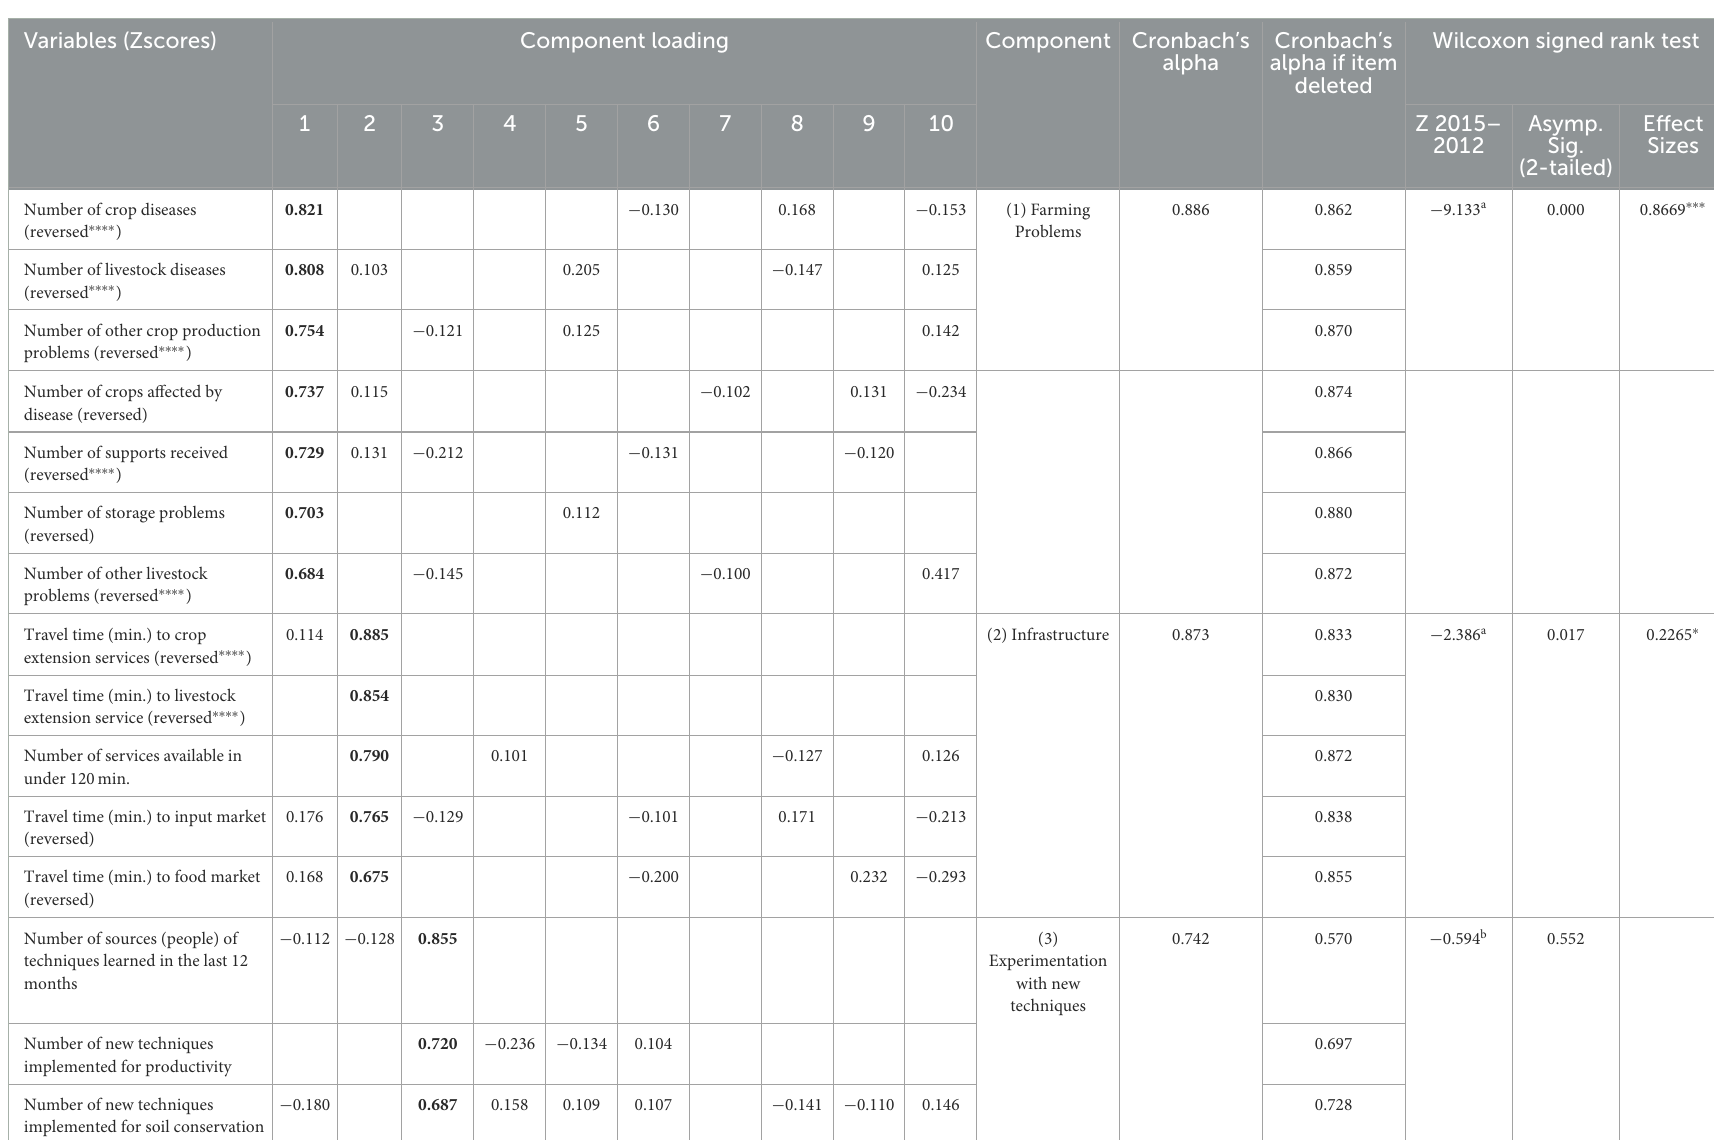
TABLE 3 Rotated component